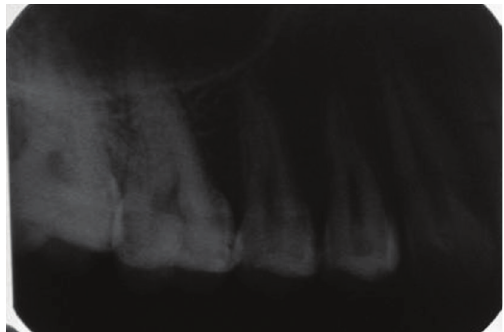
Figure 28: Intraoral periapical radiograph with 16 at 2-year